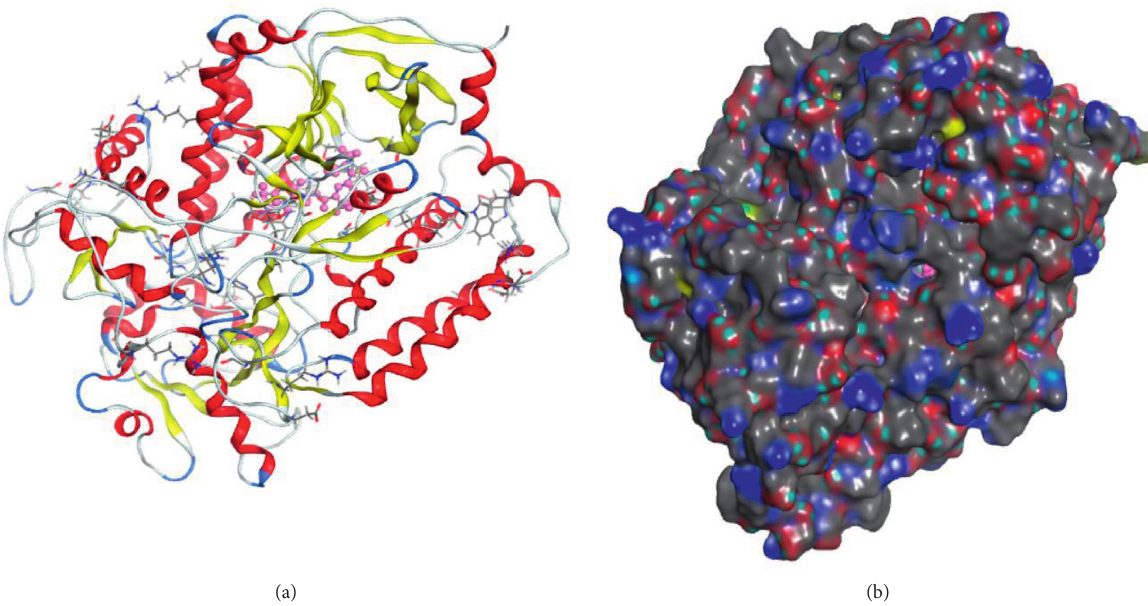
Figure 6: (a) 3D molecular interaction of DMPTHP for inhibition to 1NEK protein of E. coli . (b) 3D molecular interaction of DMPTHP for inhibition to 1NEK of E. coli inside the core on the protein